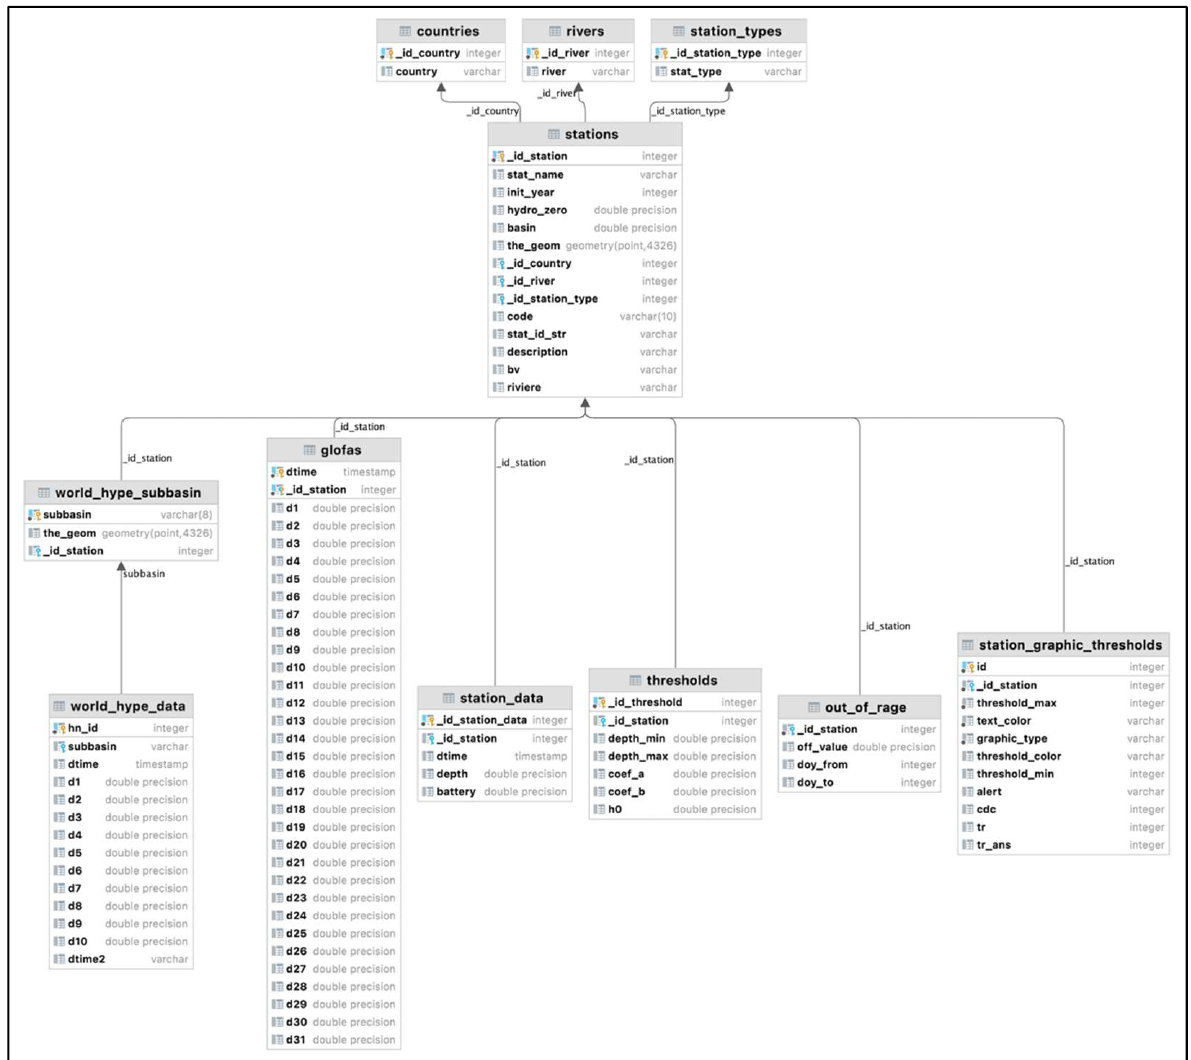
Figure 3. SLAPIS observed and forecasted data model.